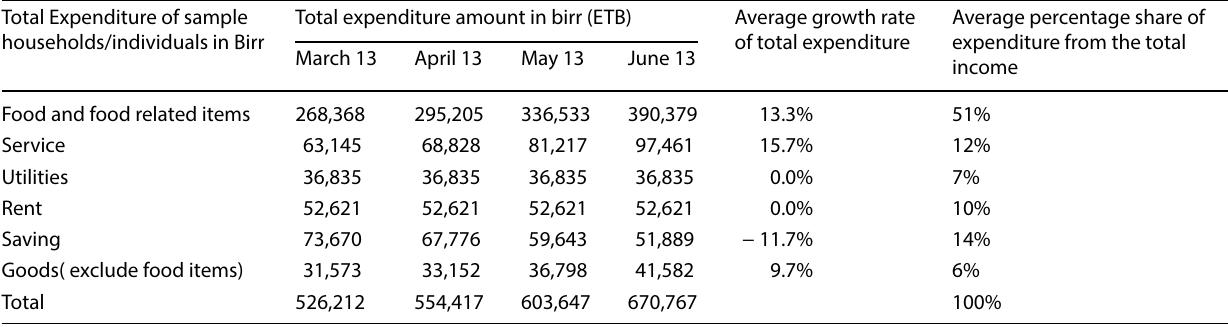
Table 5 Source, percentage share and average growth rate of